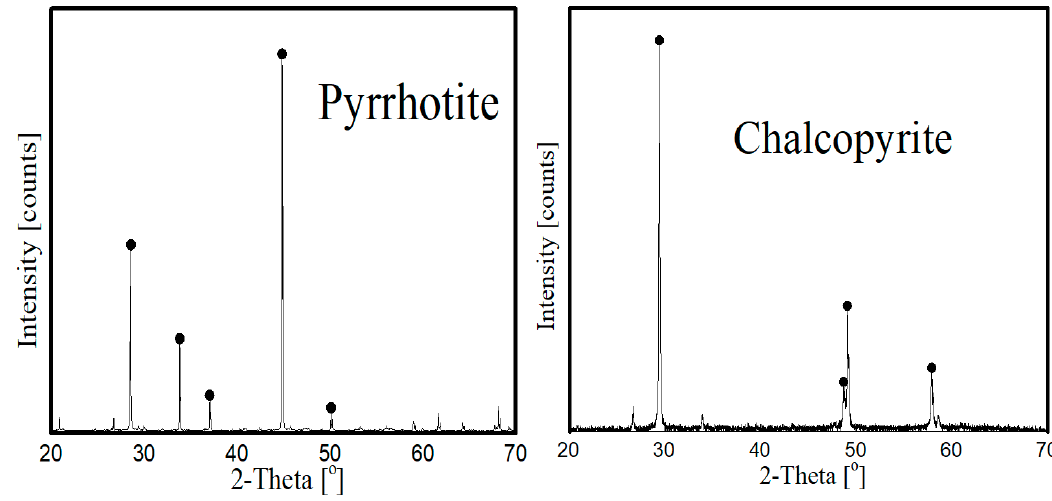
Figure 1. X-ray diffraction analysis of pyrrhotite and chalcopyrite. Figure 1. X-ray di ff raction analysis of pyrrhotite and